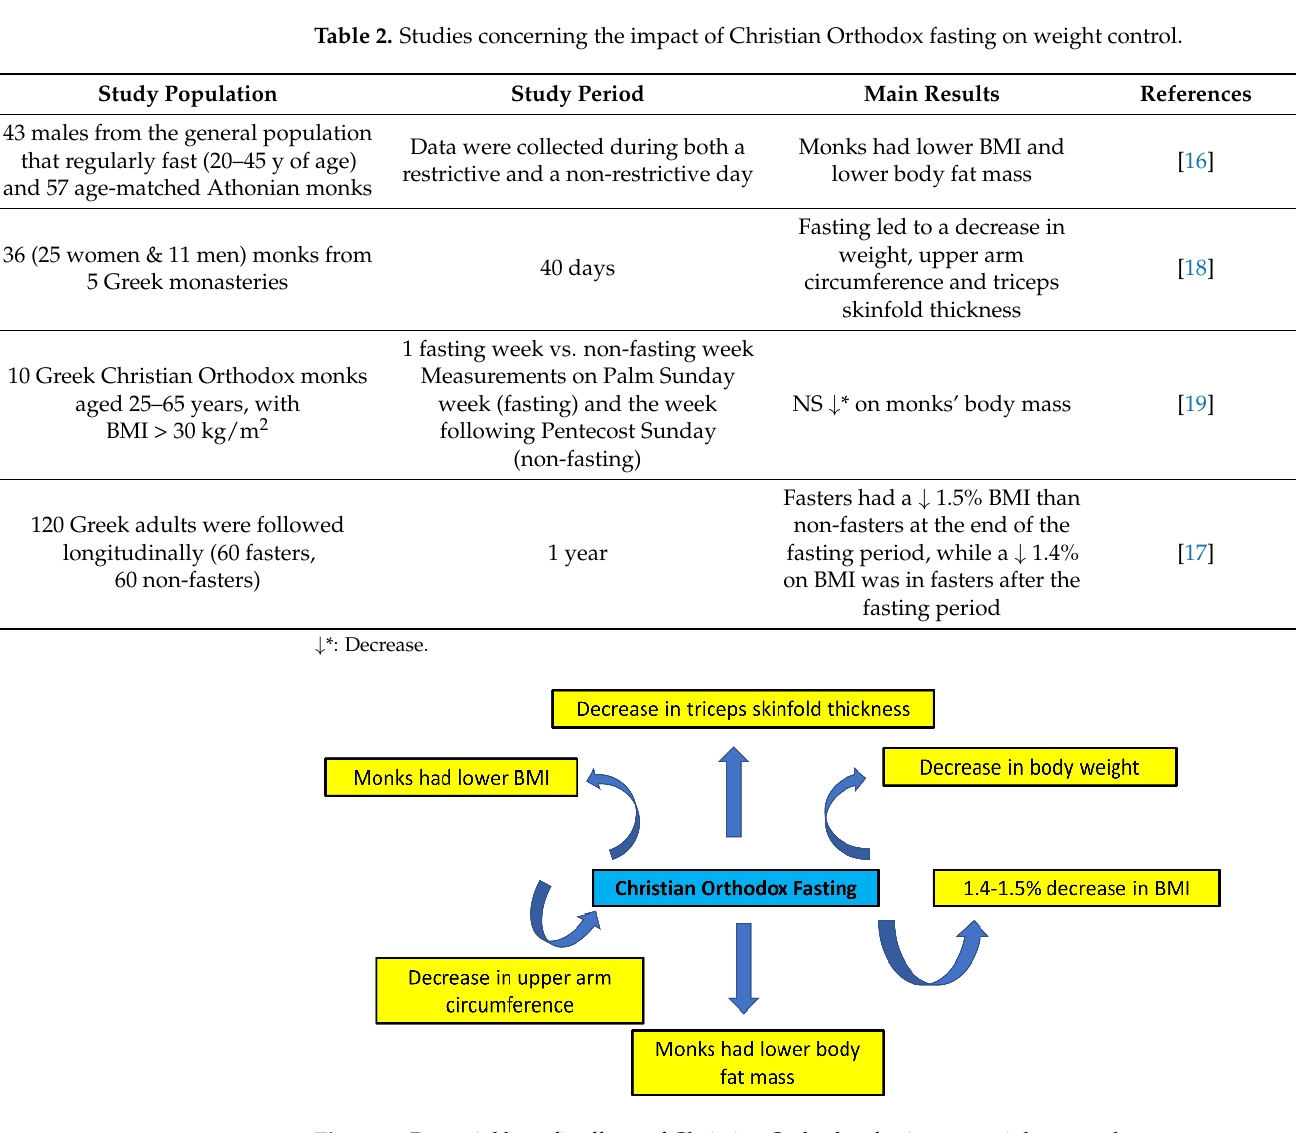
Figure 3. Potential benefit effects of Christian Orthodox fasting on weight control. Table 2. Studies concerning the impact of Christian Orthodox fasting on weight control.